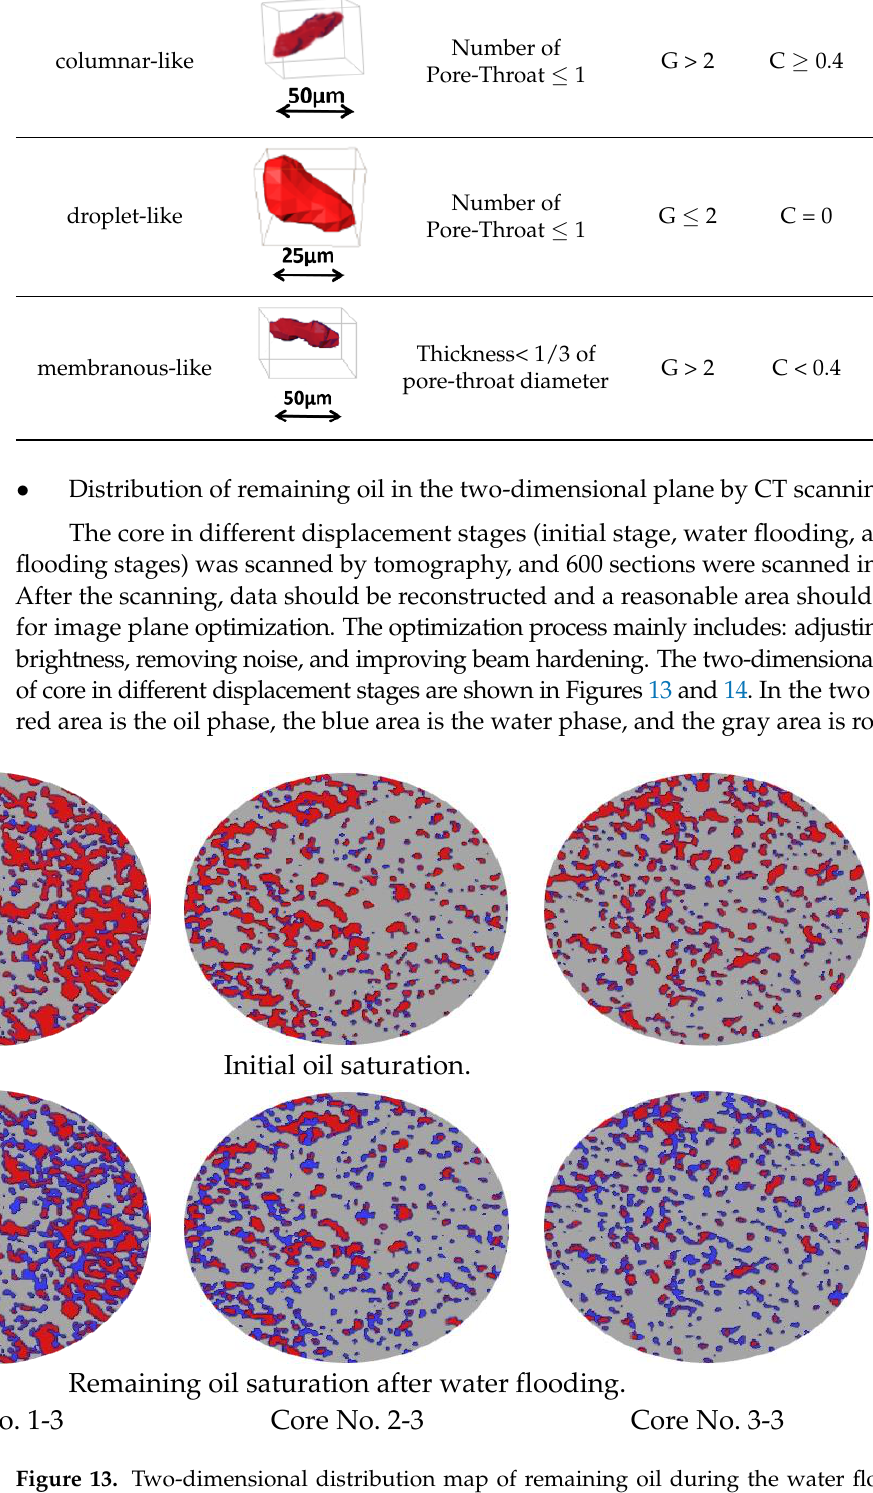
Figure 13. Two-dimensional distribution map of remaining oil during the water flooding stage constructed after CT scan.